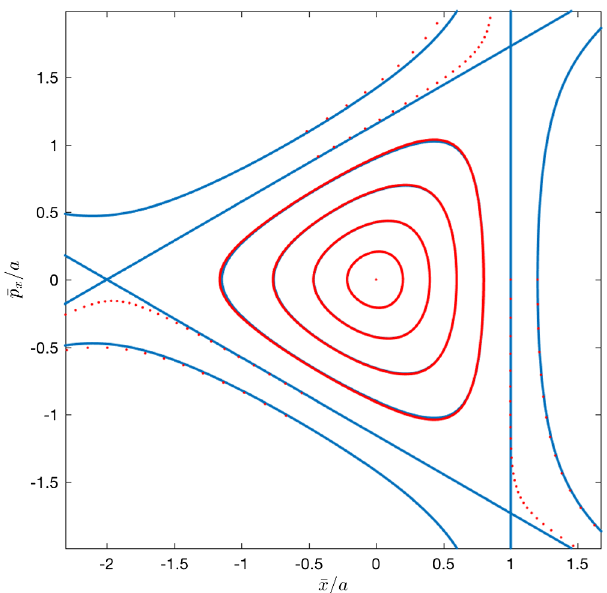
FIG. 4. Comparison of the contours (in blue color) of the effective Hamiltonian in Eq. (35) near 1 = 3 resonance with a deviation of Δ ν ¼ 0 . 005 and the orbits (in red color) by the tracking using the symplectic maps in Eqs. (4) and (5) with the cell length L ¼ 15 m and angle ϕ ¼ π = 96 .